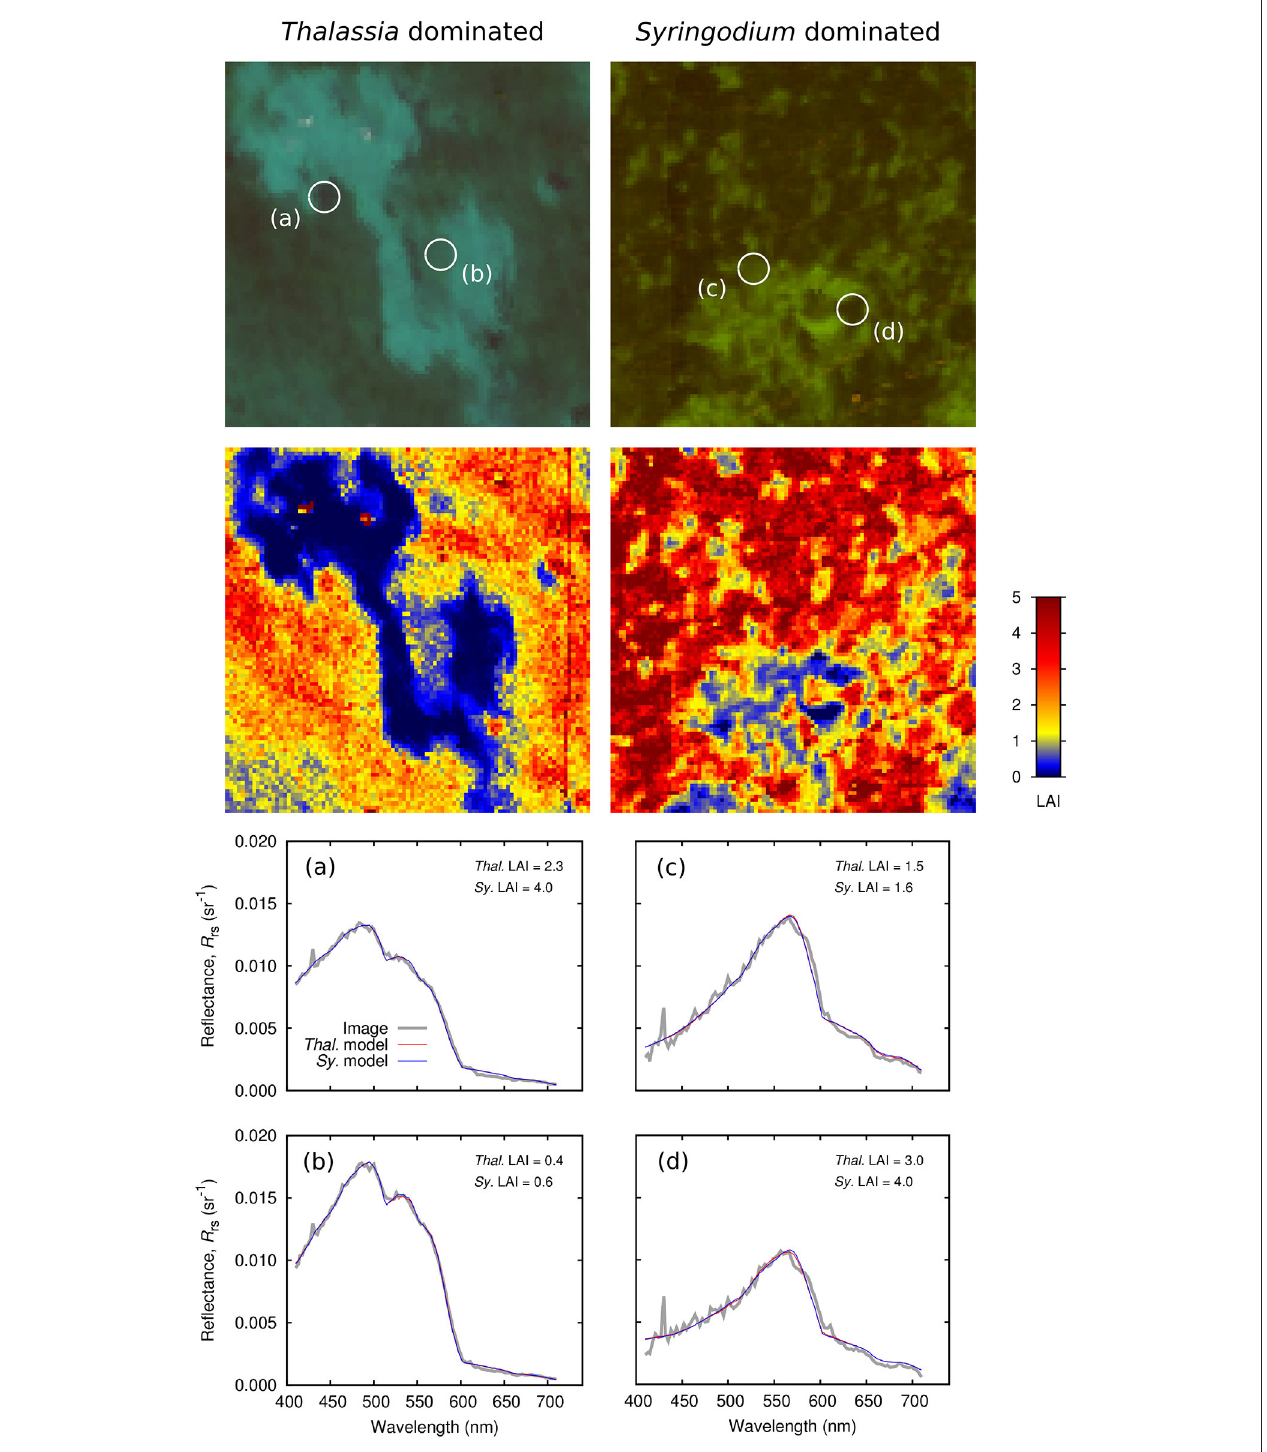
FIGURE 11 | Application of inversion model to hyperspectral PRISM imagery in (left) a Thalassia dominated area (T2 and T3) and (right) a Syringodium dominated area (S1). LAI image is from model containing all bottom compositions, (a–d) show spectral matches for models constrained to Thalassia or Syringodium only.